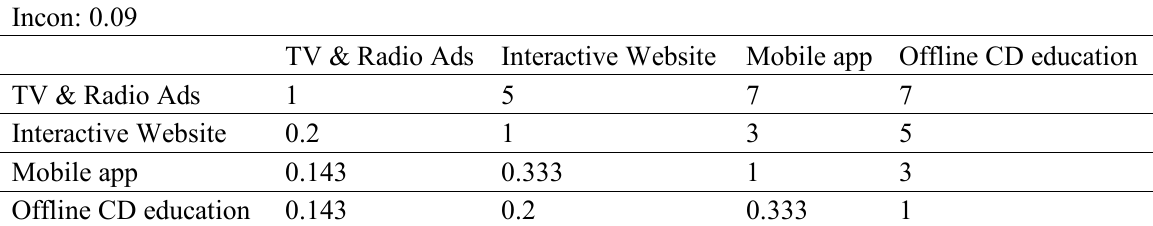
Table 2. An example of weightening matrice by AHP (Expert Choice 11) Compare the relative preference with respect to: Criteria 1 \ C11 Incon: 0.09